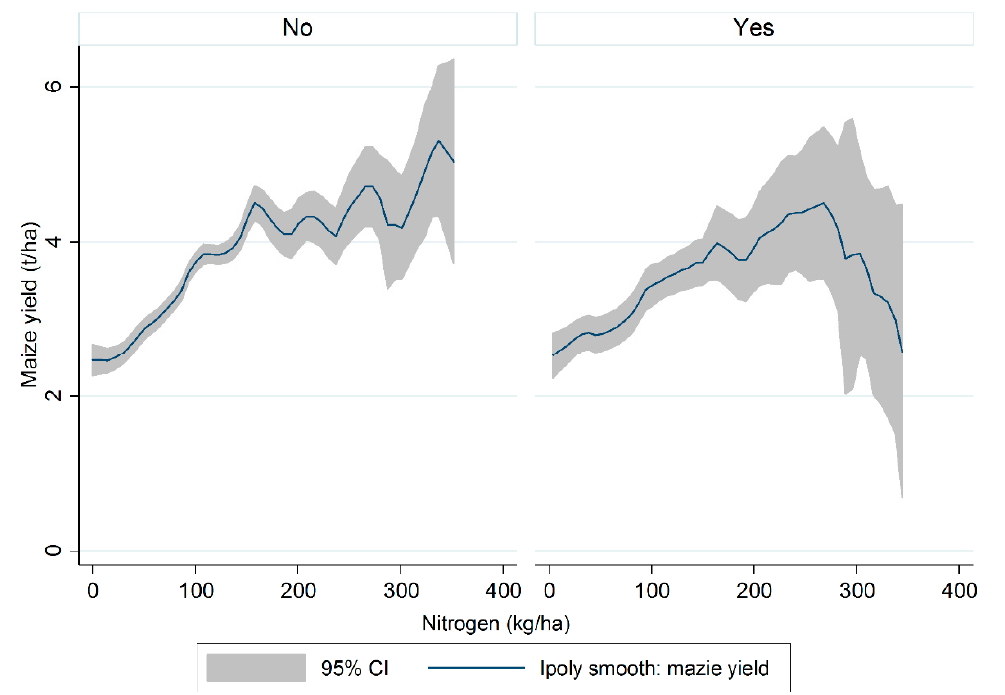
Figure 1. Maize yield in response to nitrogen fertilizer, without (No) and with (Yes) manure application. (Kernel-weighted local polynomial regression).